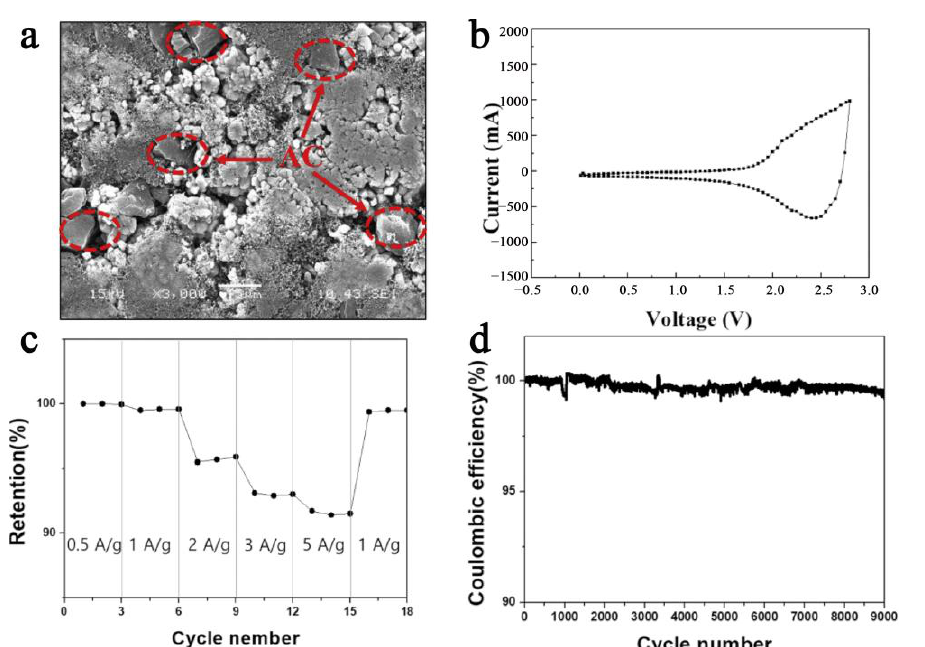
Figure 4. (NCM111 + AC)//AC LIBCs: ( a ) SEM image of the composite cathode; ( b ) CV curve; ( c ) Rate performance; ( d ) Cycle performance